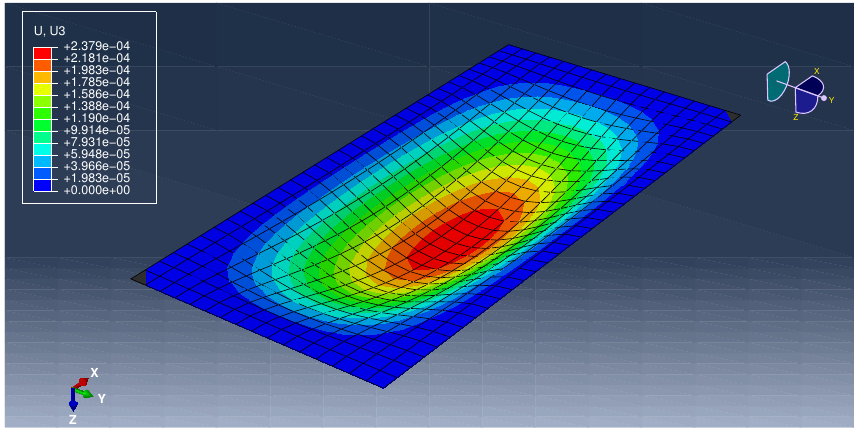
Figure A7. The deflection of a rectangular plate with clamped edges solved using